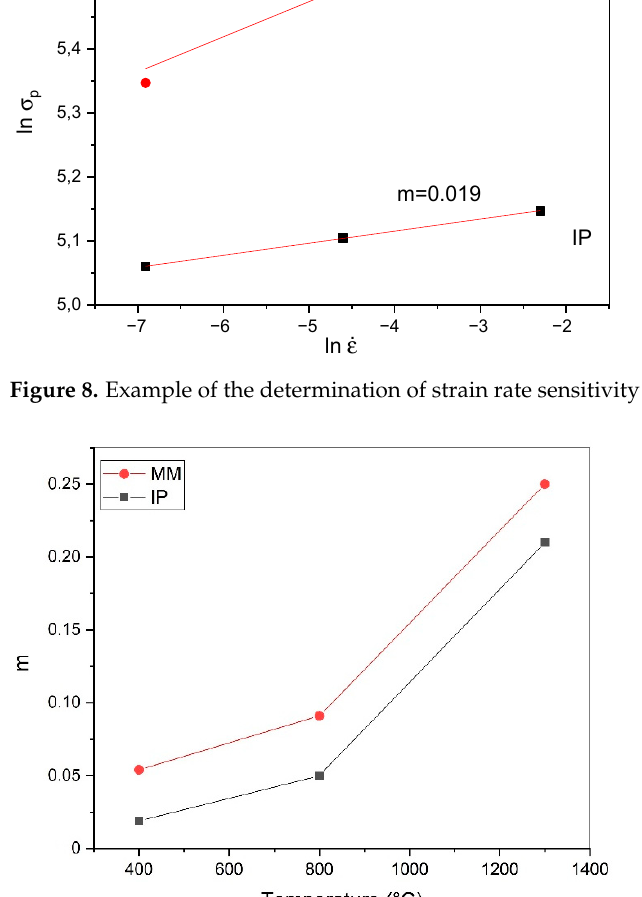
Figure 8. Example of the determination of strain rate sensitivity at 400 °C. Table 2. Values of strain rate sensitivity (m) of IP and MM.